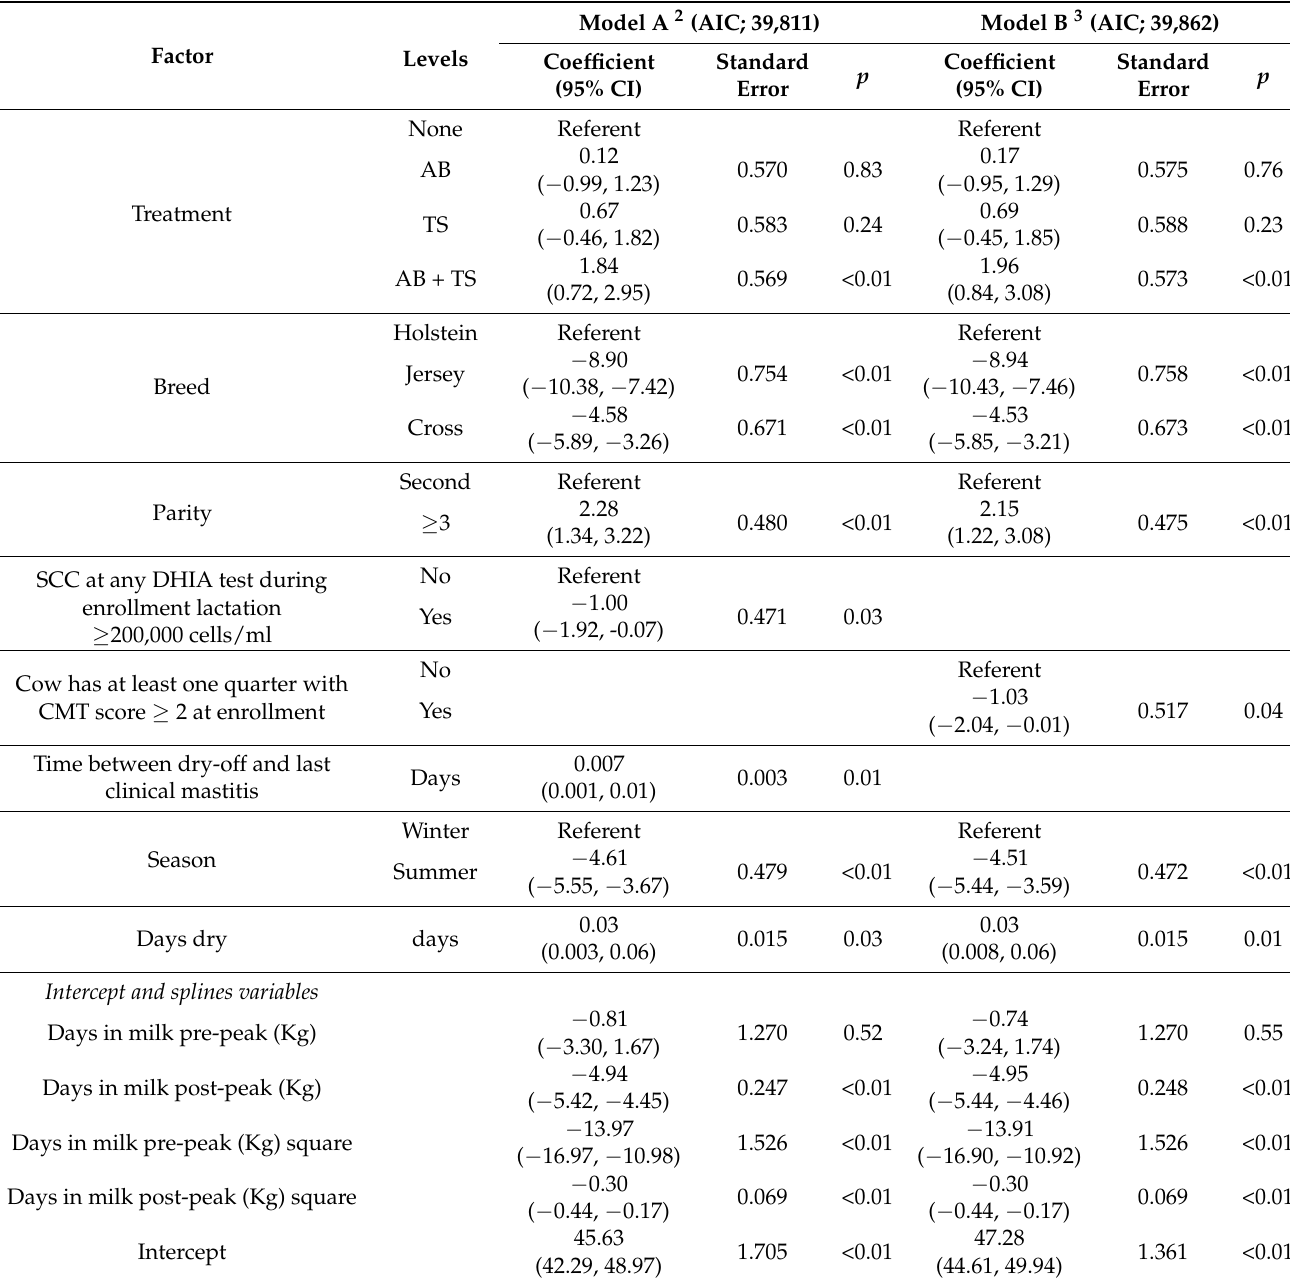
Table 3. Final two-piece spline models for test-day milk production (kg) during the first 150 DIM of dairy cows randomized at dry-off to four treatment groups (AB, TS, AB + TS, None) 1 on eight California dairies ( n = 972